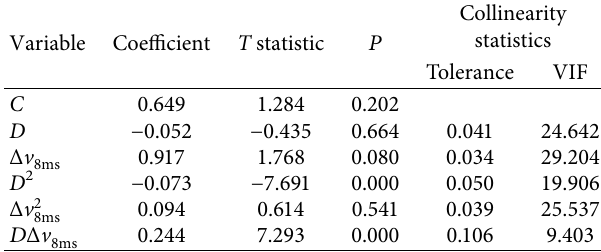
Table 16: Significance of coefficients (mean velocity variation in a certain window width).